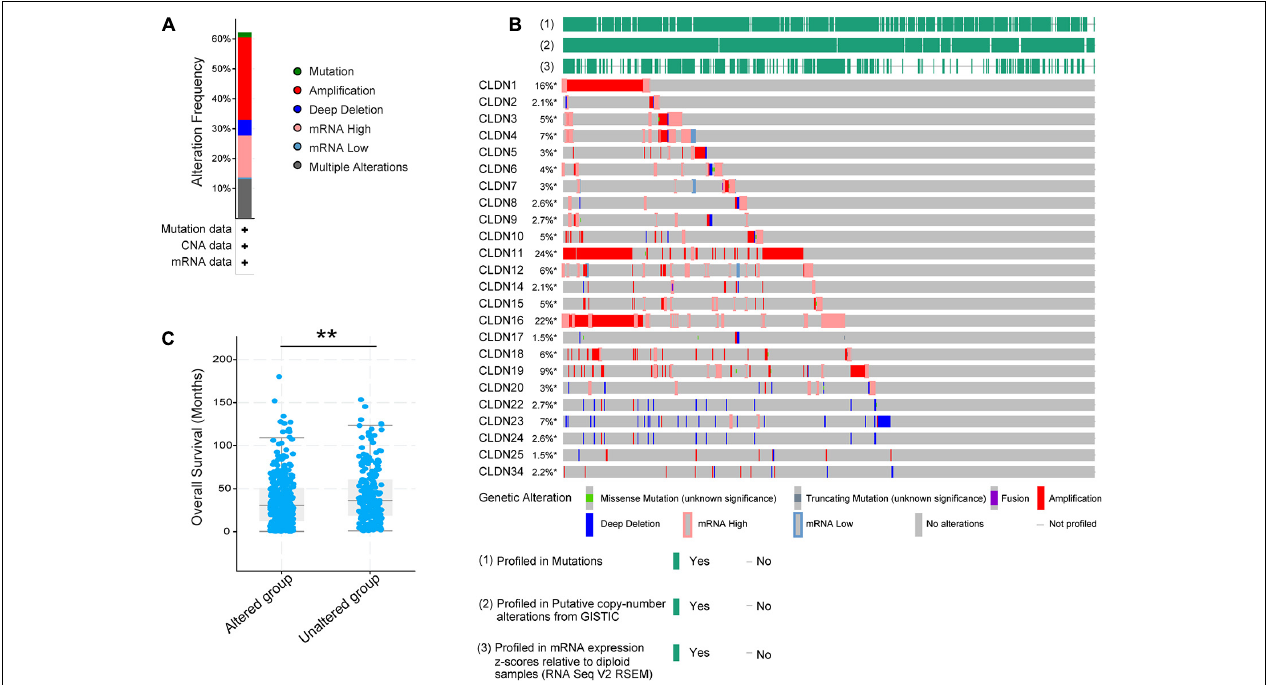
FIGURE 1 | The genetic variation of the claudin family in ovarian cancer through the cBioPortal. (A) The alteration frequency of the claudin family in serous ovarian cancer. (B) The oncoprint of the claudin family in serous ovarian cancer. (C) The overall survival difference of serous ovarian cancer between the altered and unaltered group (** p < 0.01).